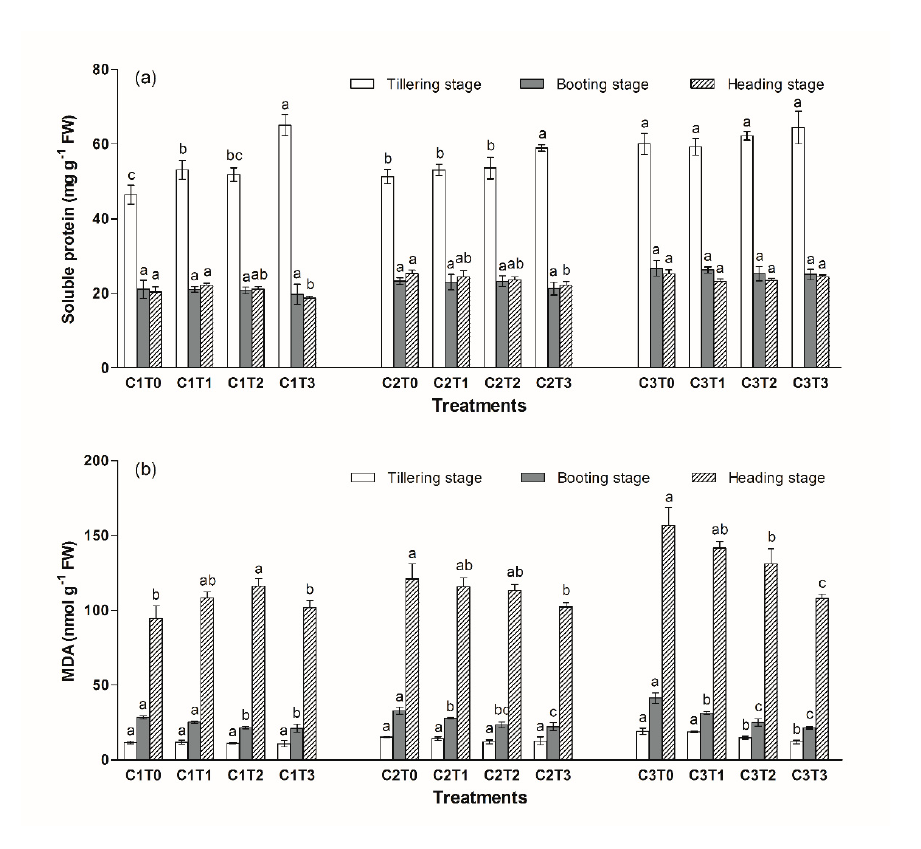
Figure 3. Changes in the soluble protein ( a ) and malondialdehyde (MDA) ( b ) in the leaves of Oryza saliva L. Different letters above columns indicate significant differences ( p < 0.05) between various treatments in same growth stage.